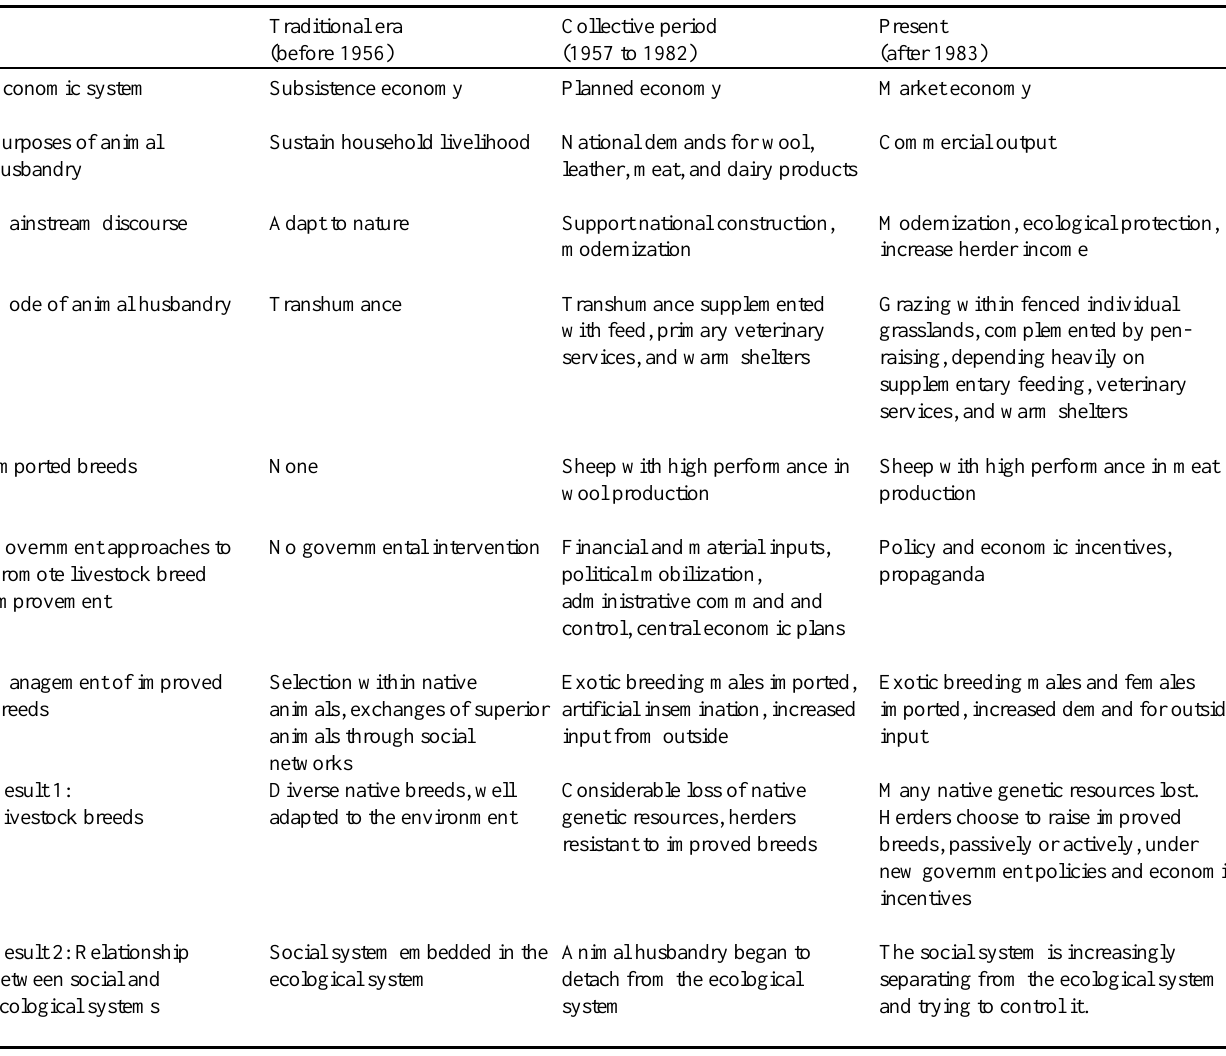
Table 2. Socioeconomic context for livestock breed management and improvement during the three study